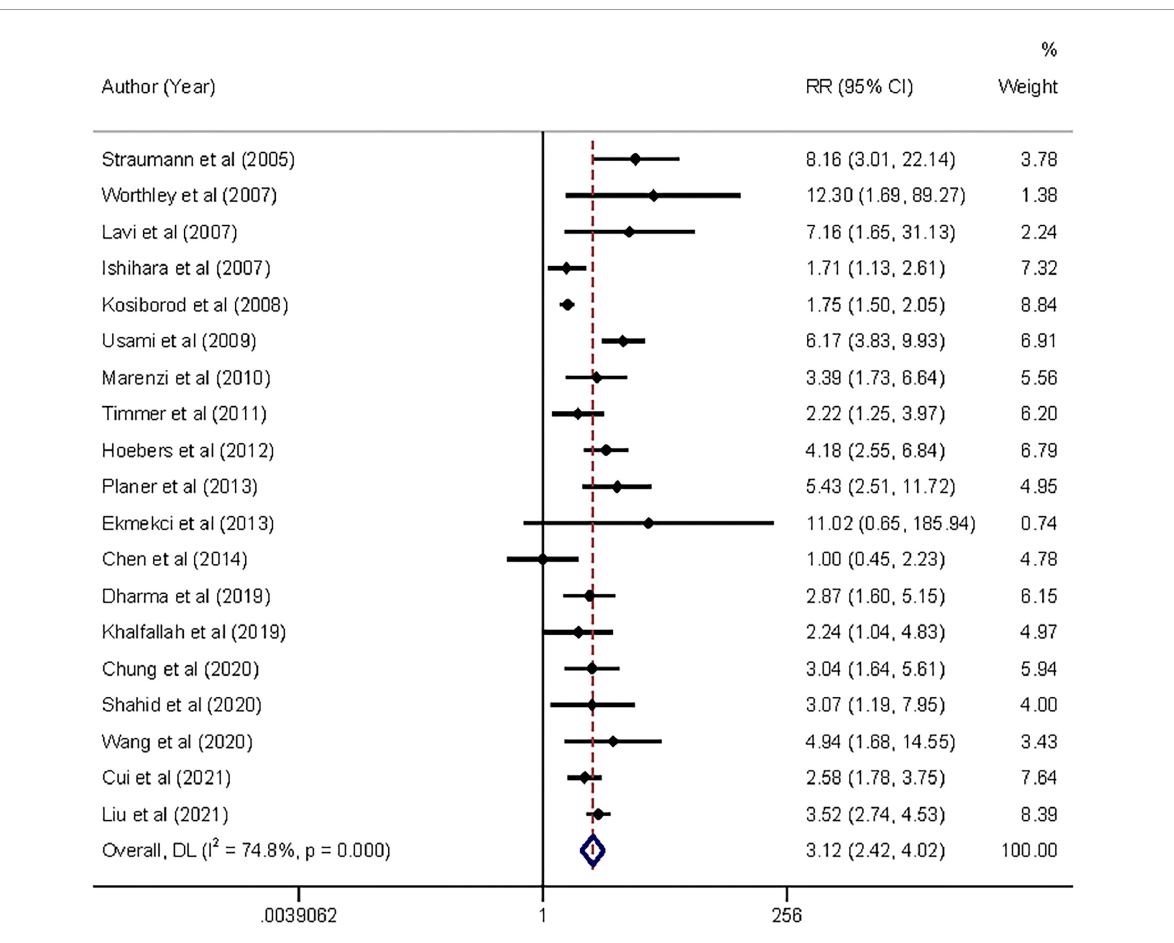
Frontiers in Cardiovascular